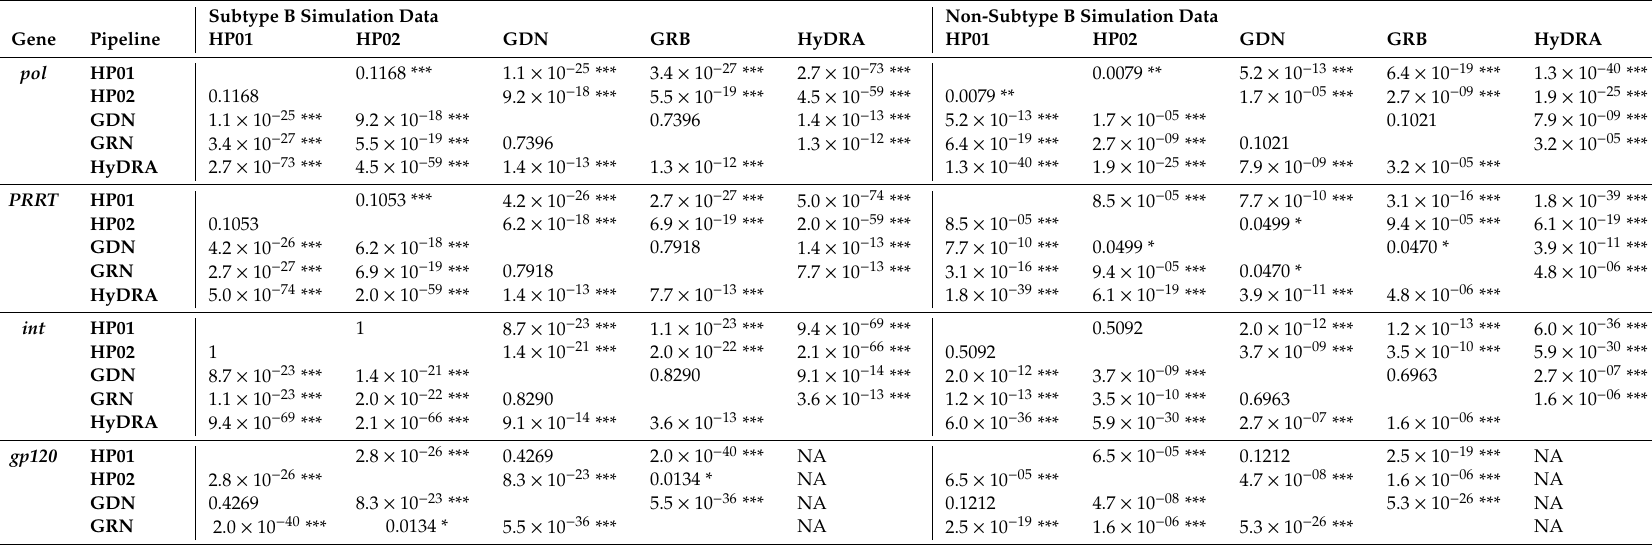
Table A2. Kruskal–Wallis multiple comparisons (Dunn test) of the adjusted genetic p-distance of the pipeline consensus sequence from the true sequence for the simulation dataset. Adjusted p -values are reported (Holm